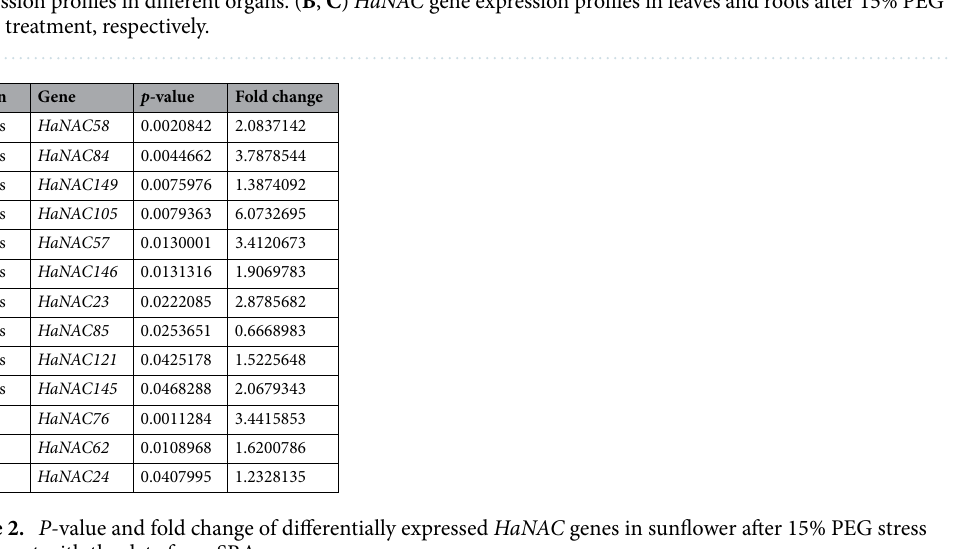
Table 2. P -value and fold change of differentially expressed HaNAC genes in sunflower after 15% PEG stress treatment with the data from